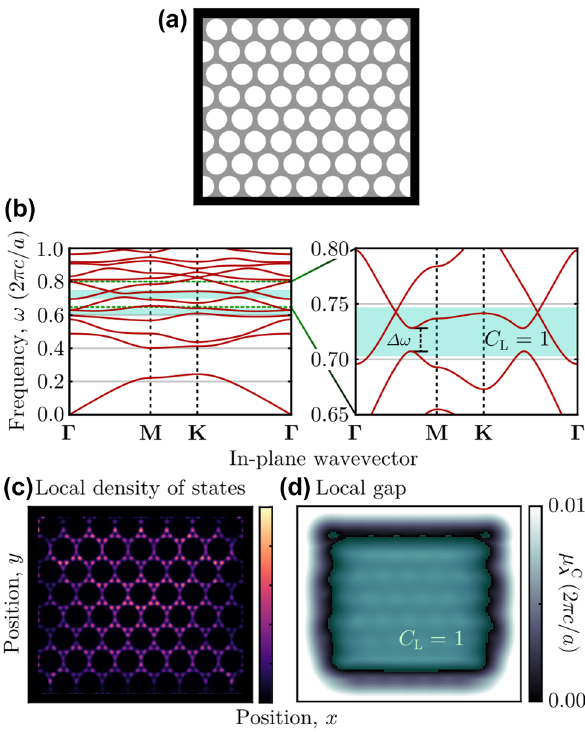
Figure 3: Identifying topology without a photonic band gap. (a) Schematic of a 2D photonic crystal of air holes with radius r = 0.4 a = 𝜀 = 12.25. Both embedded in a high-dielectric background, 𝜀 xx yy the air and background are approximated to be = − 0.24 i . The frequency-independent gyro-electric materials, 𝜀 xy lattice constant is a and all materials have 𝜇 = 1. The black boundary indicates where perfect electric conductor boundary conditions were used. (b) Bulk band structure of this photonic crystal’s TE modes, lime-colored regions indicate frequency ranges = 1. The zoomed in right panel indicates one of the where C L topological frequency ranges, with the local band gap, Δ 𝜔 , component of the indicated. (c) Local density of states for the H z fields for 𝜔 = 0.720(2 𝜋 c ∕ a ). (d) 2D local gap and local Chern number for 𝜔 = 0.720(2 𝜋 c ∕ a ) and 𝜅 = 0.10. For both (c) and (d), the spatial scale is the same as the system shown in (a). that does not close the incomplete band gap, regardless of the absence of a complete band